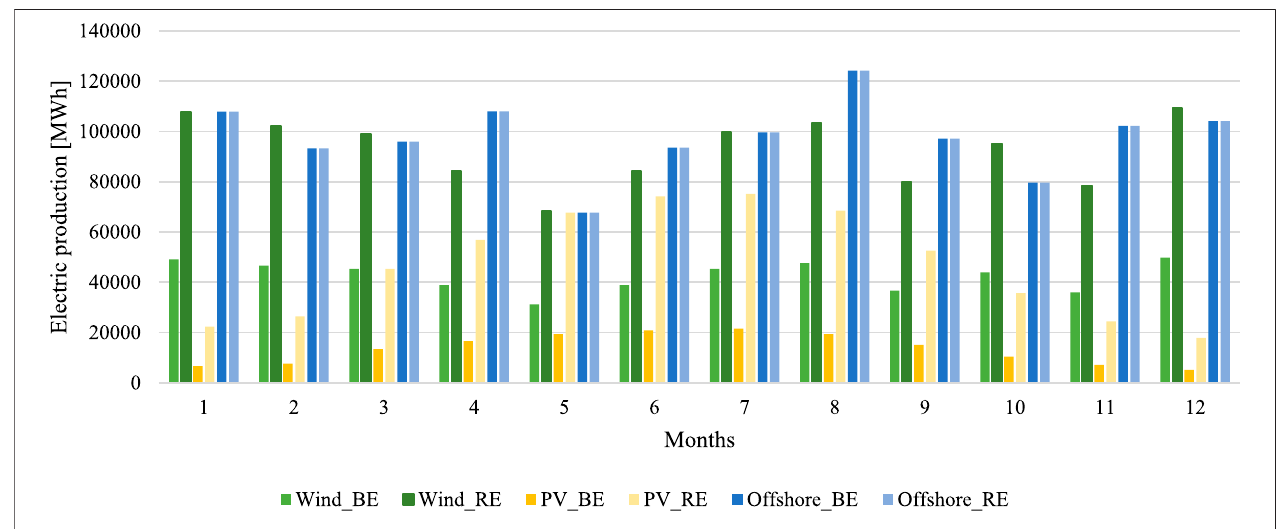
FIGURE 8 | Monthly production from electricity sources in Blue Energy and Renewable